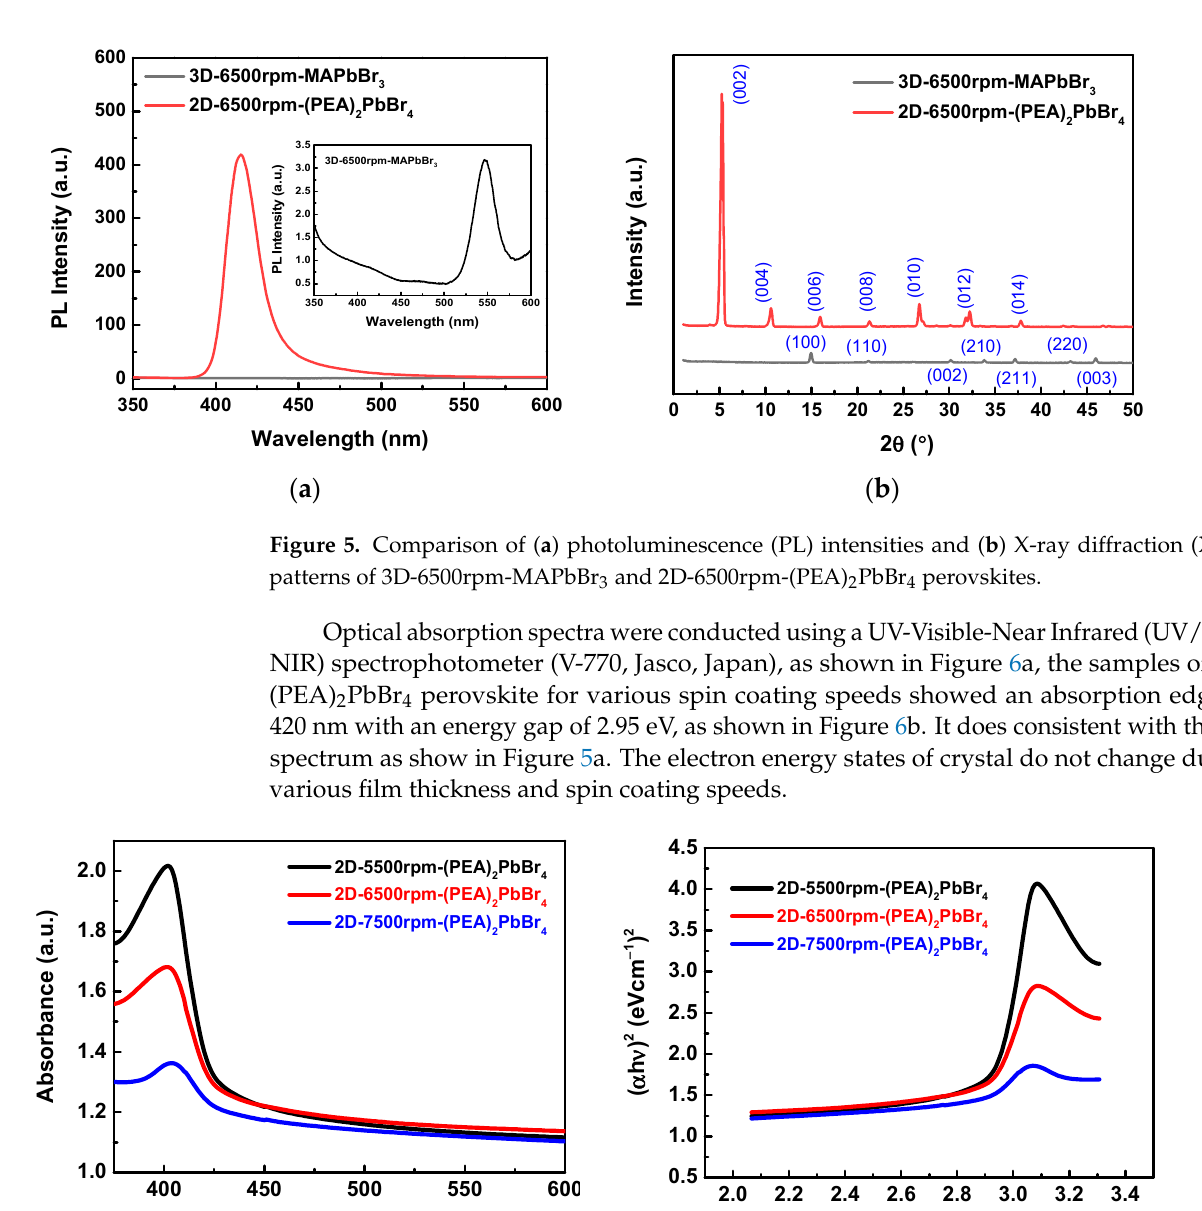
the film formed at 5500 rpm had more grain boundaries than that formed at 6500